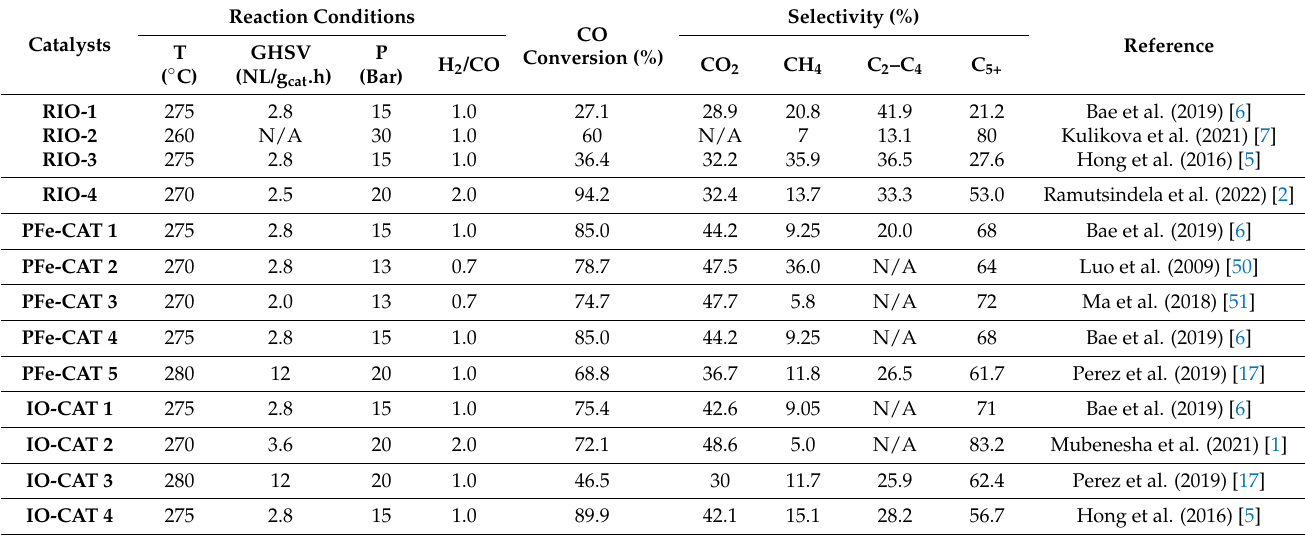
Table 3. FT catalytic performance of raw iron ore during LTFT conditions versus conventional iron